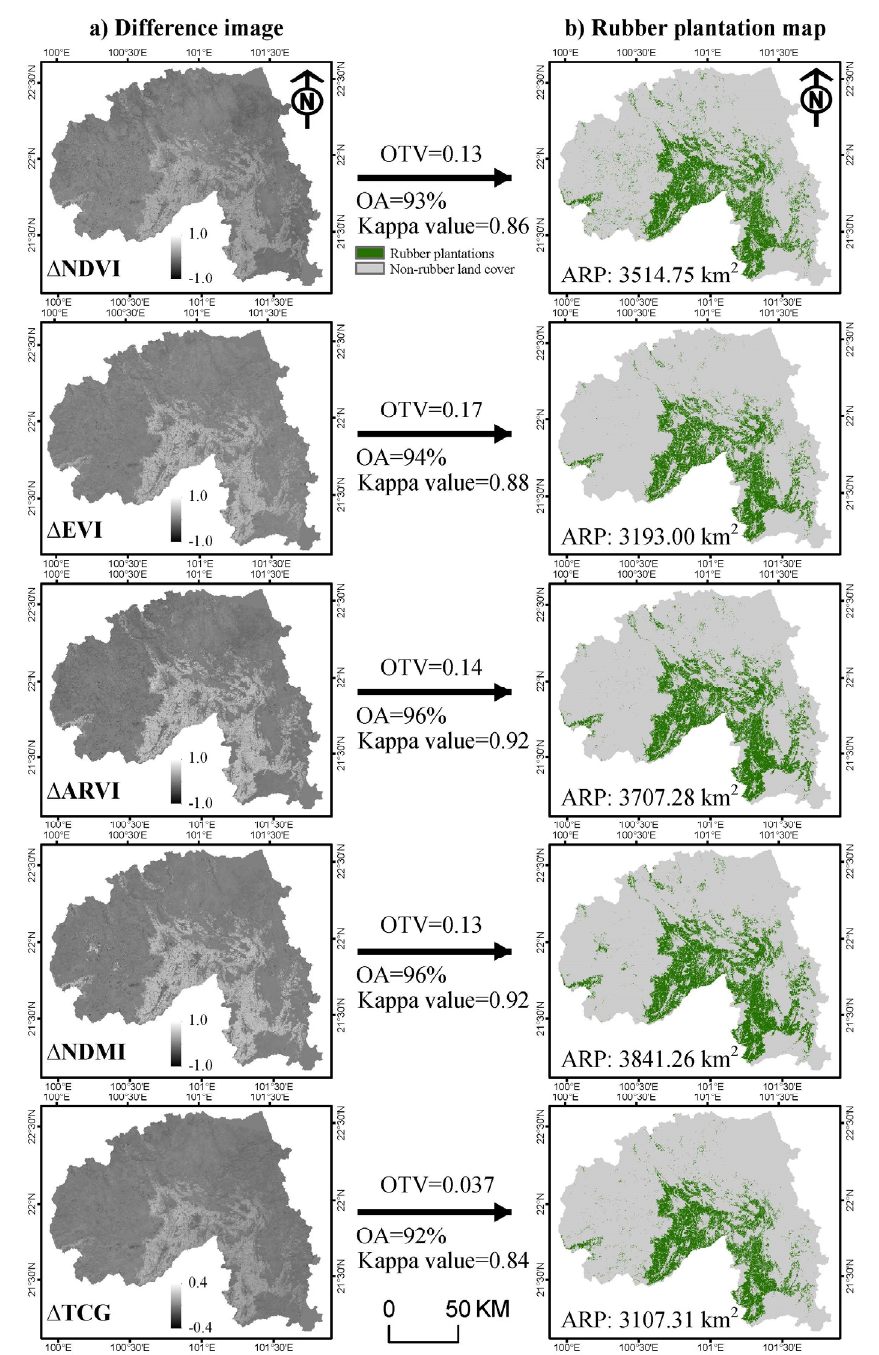
Figure 4. Difference images ( a ) of the five spectral vegetation indices from the two images acquired on 13 March 2014 (cloud-contaminated pixels were filled with the cloud-free pixels from 29 March 2014) and on 9 February 2014, and the rubber plantation maps ( b ) obtained by thresholding these difference images. The areas of the rubber plantations (ARP) in these maps were calculated and are shown in ( b